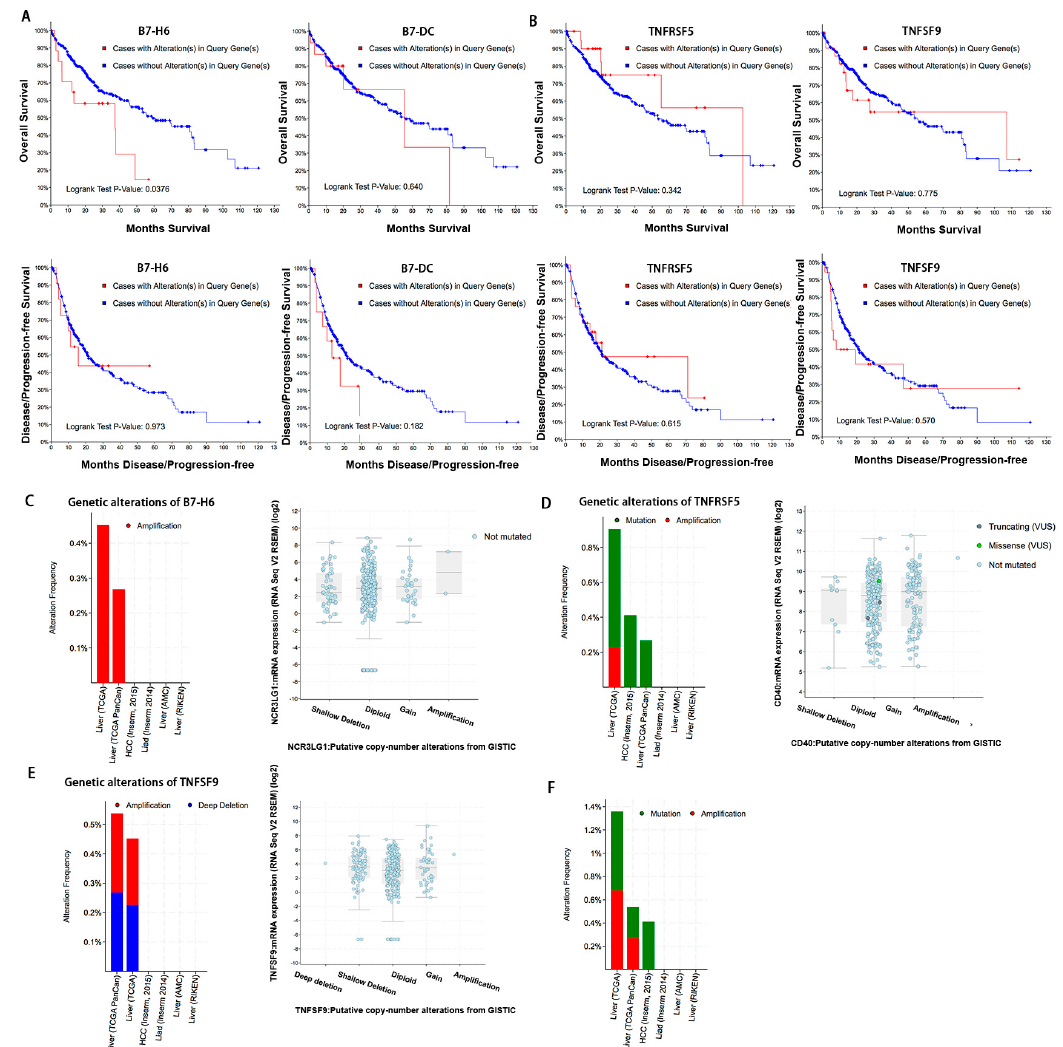
Figure 4. B7-H6 is a potential biomarker in HCC. ( A ) Overall survival (OS) and disease-free survival (DFS) of patients with B7-H6 and B7-DC alterations in HCC. ( B ) Overall survival (OS) and disease-free survival (DFS) of patients with TNFRSF5 and TNFSF9 alterations in HCC. ( C ) B7-H6 genetic alteration in six studies from cBioPortal and B7-H6 mRNA levels with copy number variations in HCC samples. ( D ) TNFRSF5 genetic alteration in six studies from cBioPortal and TNFRSF5 mRNA levels with copy number variations in HCC samples. ( E ) TNFSF9 genetic alteration in six studies from cBioPortal and TNFSF9 mRNA levels with copy number variations in HCC samples. ( F ) Both B7-H6 and TNFRSF5 gene alterations in six studies from cBioPortal. P values were determined using the log-rank test.